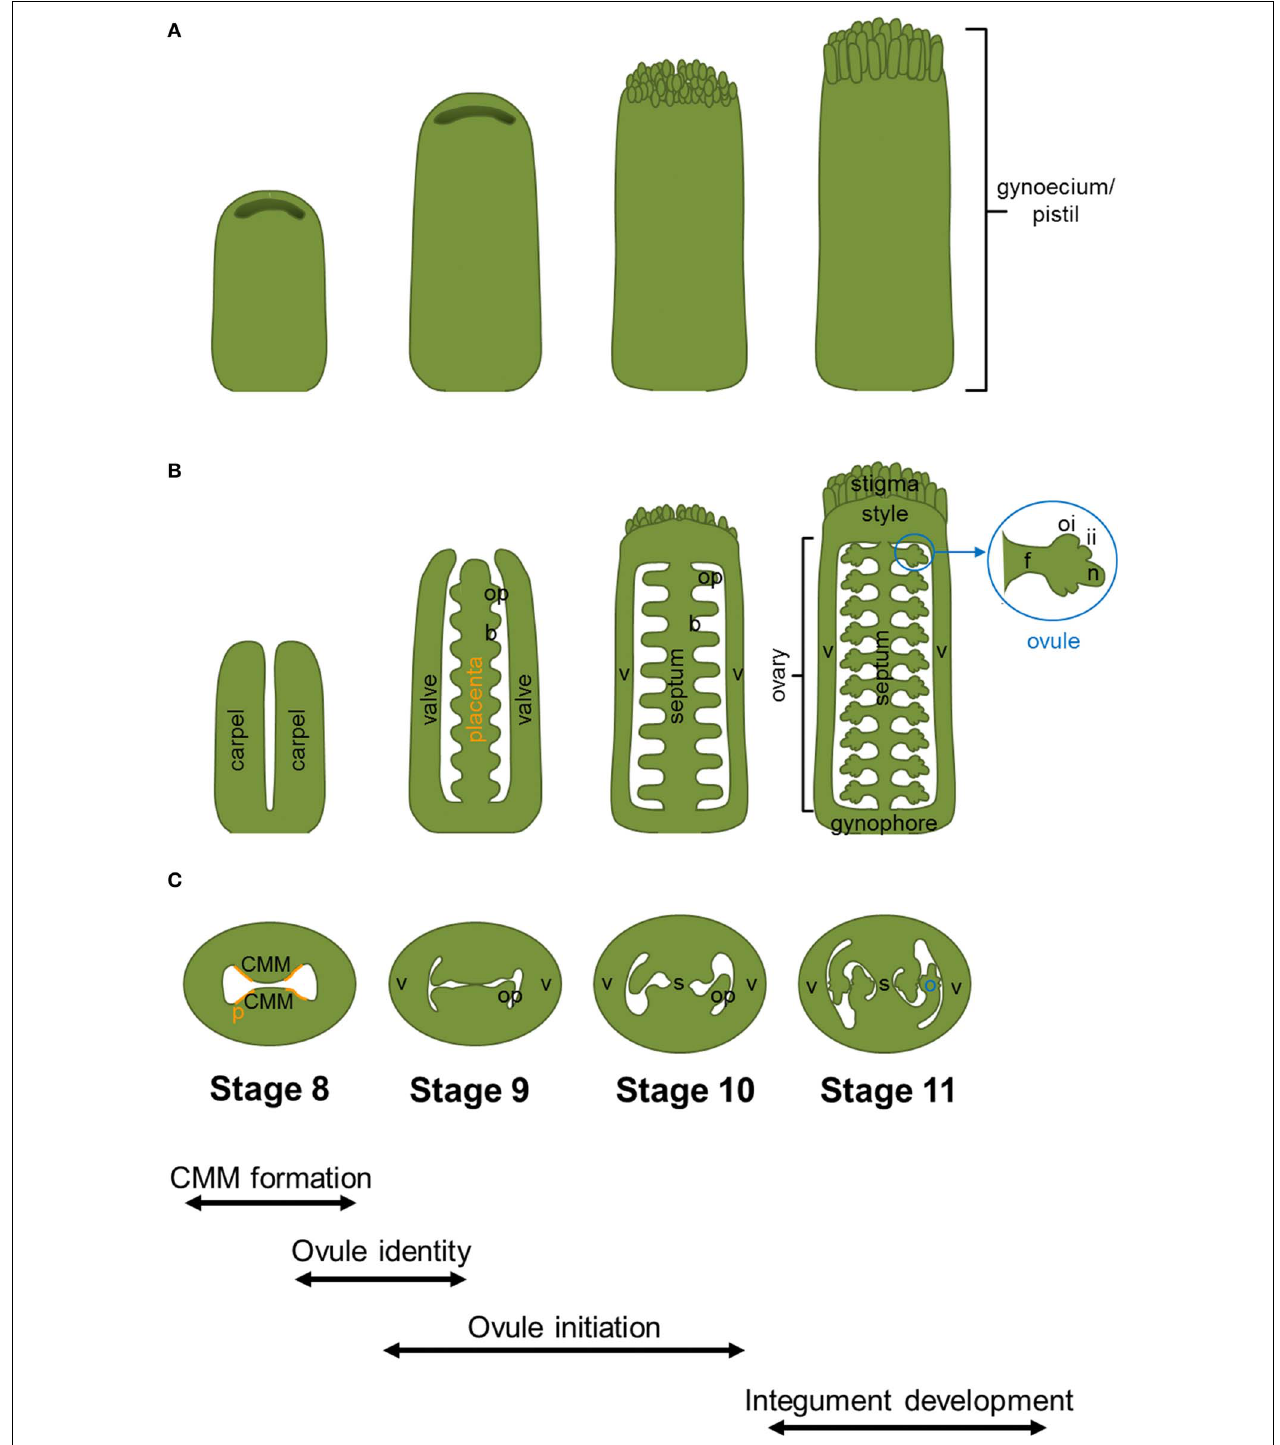
FIGURE 1 | Arabidopsis thaliana gynoecium development. Cartoons displaying wild-type gynoecia (A) , in longitudinal sections (B) , and transversal sections (C) from stage 8 to 11. The different stages and processes of gynoecium and ovule development are indicated at the bottom of the figure.